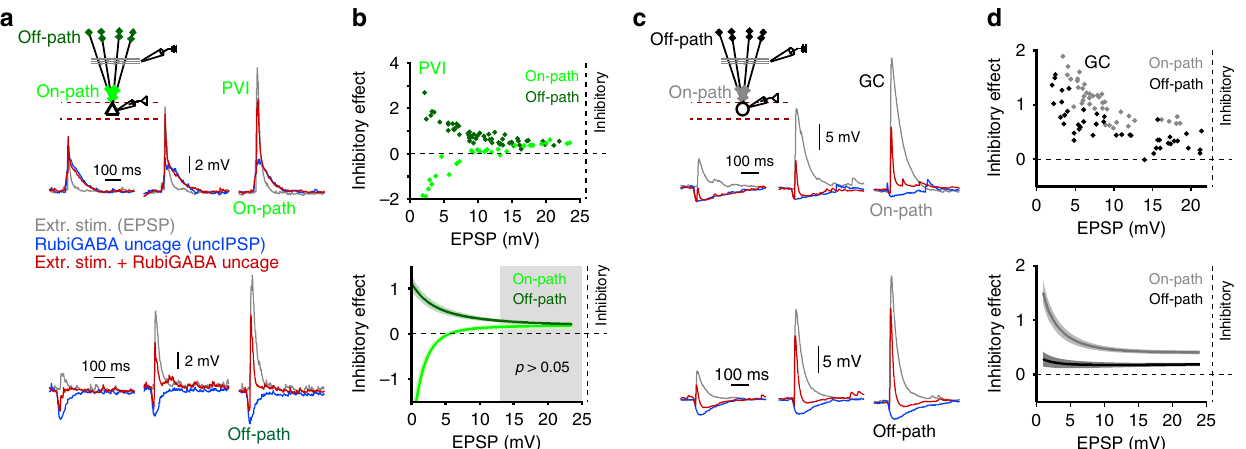
Fig. 3 Inhibitory ef fi ciency differentially depends on excitatory drive onto PVIs and GCs. a , c Inset, schematic illustration of the experimental design. Subthreshold EPSPs were evoked by extracellular stimulation (extr. stim; 0.1 – 0.2 ms) of the perforant path on the level of the middle molecular layer (gray lines) at a distance of ~150 µ m to the recorded soma of PVIs ( a ) and GCs ( c ). IPSPs were evoked by sequential RubiGABA uncaging at seven randomly chosen proximal on-path (PVI bright green, GC gray fi lled circles) at the level of the inner molecular layer (25 – 75 µ m distance to soma), or seven distal off- path (PVI dark green, GC black fi lled circles) spots in the outer molecular layer (200 – 250 µ m distance to soma) distributed at apical dendrites of PVIs and GCs (0.5 ms uncaging duration, 2 ms inter-pulse interval between individual seven uncaging locations), prior to extracellular stimulation. Superimposed traces are individual EPSPs during control conditions (gray), uncIPSPs (blue) and PSPs evoked by extracellular stimulation and RubiGABA uncaging (red) at three extracellular stimulation intensities shown from left to right for on-path (upper set of traces) and off-path inhibition (lower set of traces). b , d Inhibitory effect of RubiGABA uncaging was plotted against EPSP amplitudes for on- and off-path inhibition in PVIs ( b ) and GCs ( d ). Upper graphs depict representative results from individual cells. Lower graphs summarize data from all experiments (14 PVIs, 19 GCs). Data were fi tted with a single exponential function (Methods). Note, on-path inhibition was signi fi cantly more ef fi cient across EPSP amplitudes in nongray areas for PVIs and for all EPSP amplitudes for GCs than off-path inhibition ( p ≤ 0.05). Circles represent individual data points, lines with shades represent mean ± s.e.m. Gray square in ( b ) depicts area of no signi fi cant difference between on- and off-path inhibitory effects ( p ≥